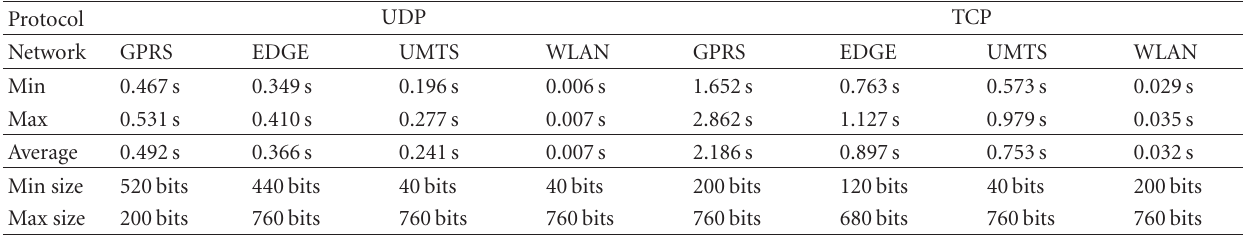
Table 2: Transfer time for various wireless networks (40–760